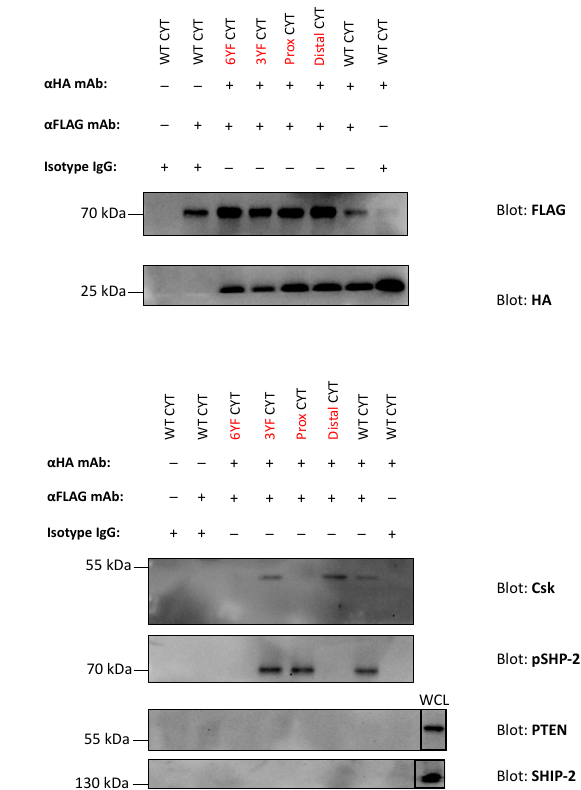
Figure 7. Co-immunoprecipitation of the selective recruitment of Csk and pSHP-2 to various 1.1b WT CYT constructs following co-crosslinking with 2.6b ITAM CYT . AD293 cells (3 × 10 5 ) co-expressing 2.6b ITAM CYT and the various 1.1b CYT constructs were incubated at 37 ◦ C for 8 min with 3 µ m magnetic beads (3 × 10 6 ) opsonized with the indicated mAbs and / or isotype IgG1 (’ + ’ and ‘ − ’ indicate the presence and absence of corresponding antibodies on beads, respectively). Cells were immediately lysed on ice for 30 min and then magnetic beads were separated, washed three times, and eluted before separating bead-bound proteins using SDS-PAGE. Separated proteins were transferred to nitrocellulose membranes and then probed with α -FLAG and α -HA mAbs ( A ) to verify successful pull-down of the various 1.1b CYT constructs (top membrane) and 2.6b ITAM CYT (bottom membrane). Co-immunoprecipitation of potential e ff ector molecules ( B ) was further examined by probing membranes with α -Csk, α -pSHP-2, α